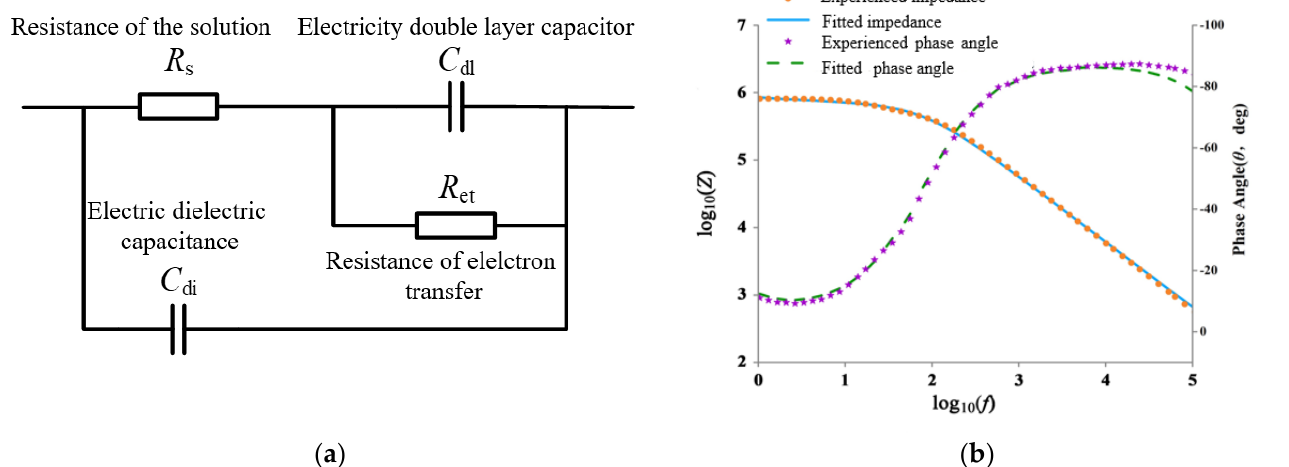
Figure 5. Equivalent circuit and simulation result. ( a ) Diagram of equivalent circuit. ( b ) Fitted curves of impedance and phase angle of 10 μg·m L − 1 ToRSV.